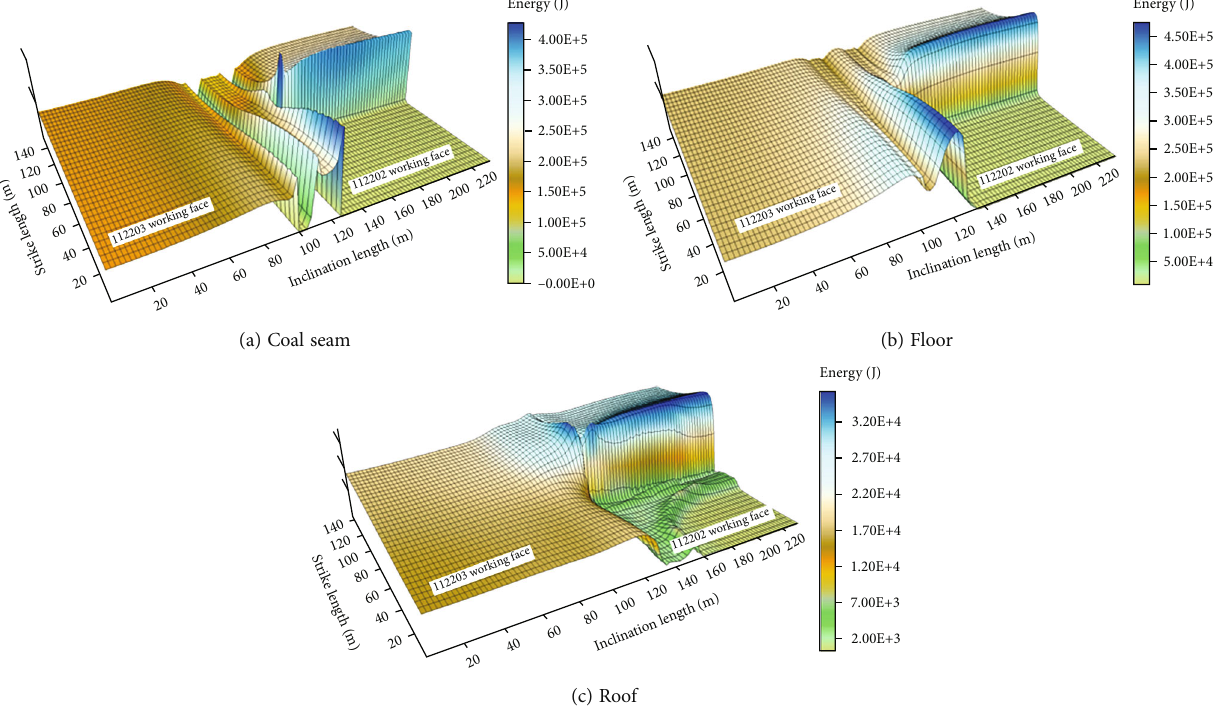
Figure 11: Energy distribution characteristics of the surrounding rock in hydraulic fracturing roof cutting of the roadway during primary